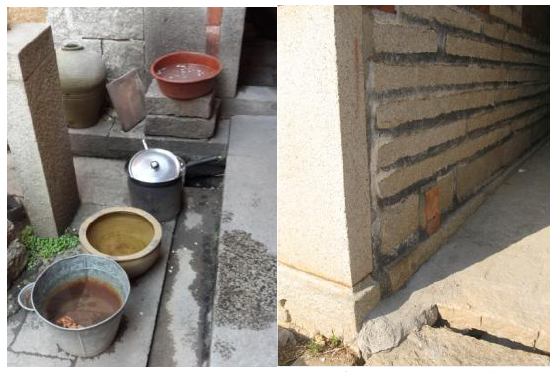
Figure 9. Drainage outlet of patio and cat